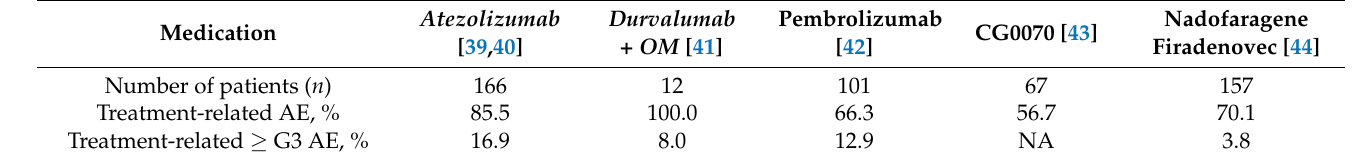
Table 3. General treatment-related adverse events (AEs) presented in percentage terms, classified according to the Common Terminology Criteria for Adverse Events (CTCAE) in all included studies ( Italics : preliminary data; NA = not